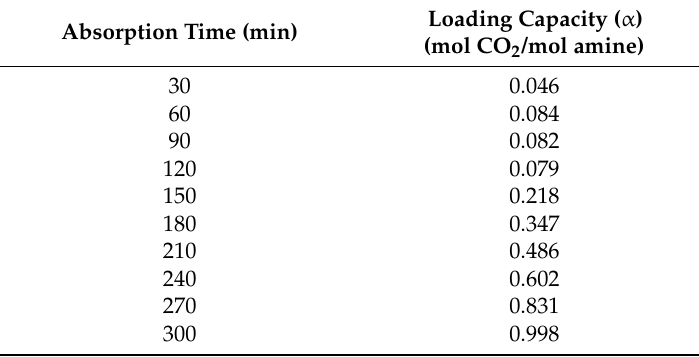
Table 3. Results from CO 2 absorption by the aqueous MDEA solution at 20% ( w / w ) by the precipitation method in the larger pilot